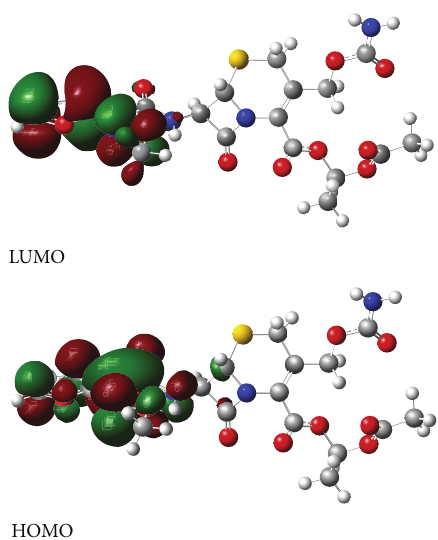
Figure 5: Frontier molecular orbitals of cefuroxime